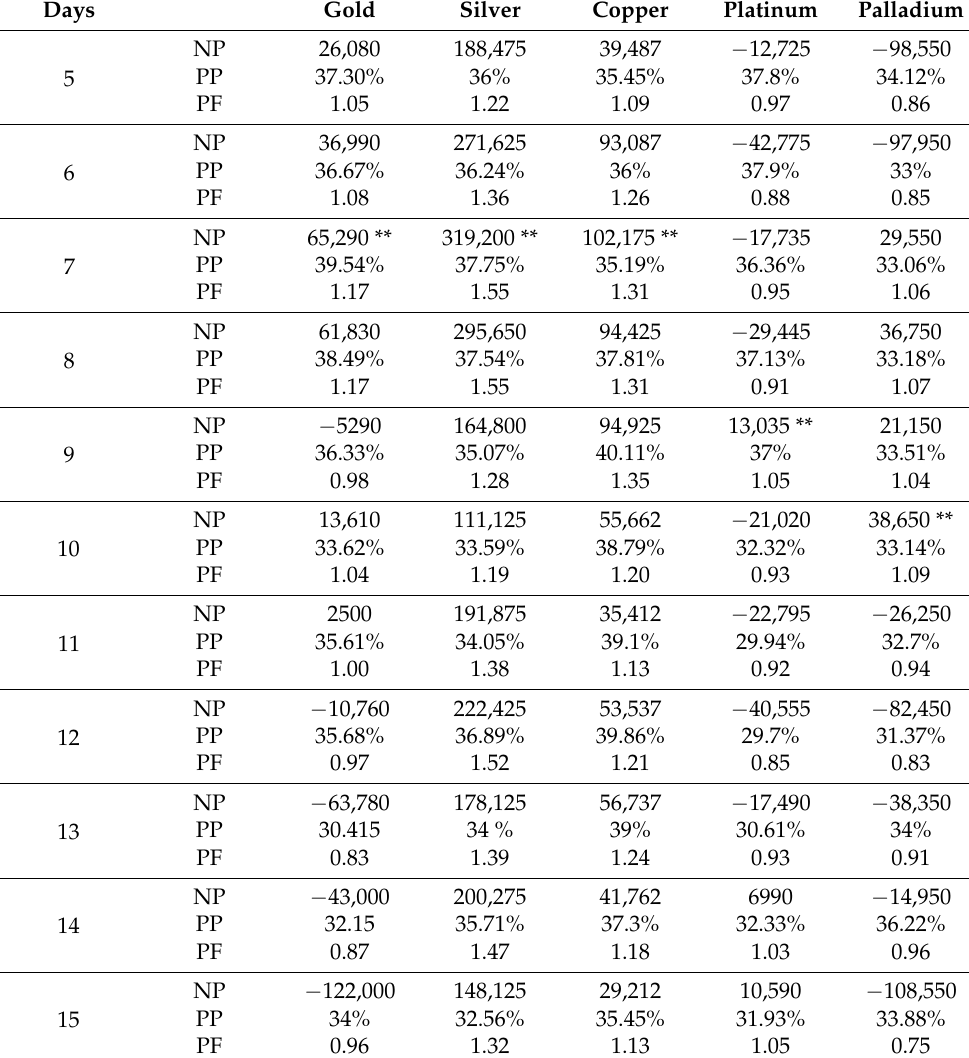
Table 5. Darvas boxes strategy trading results.